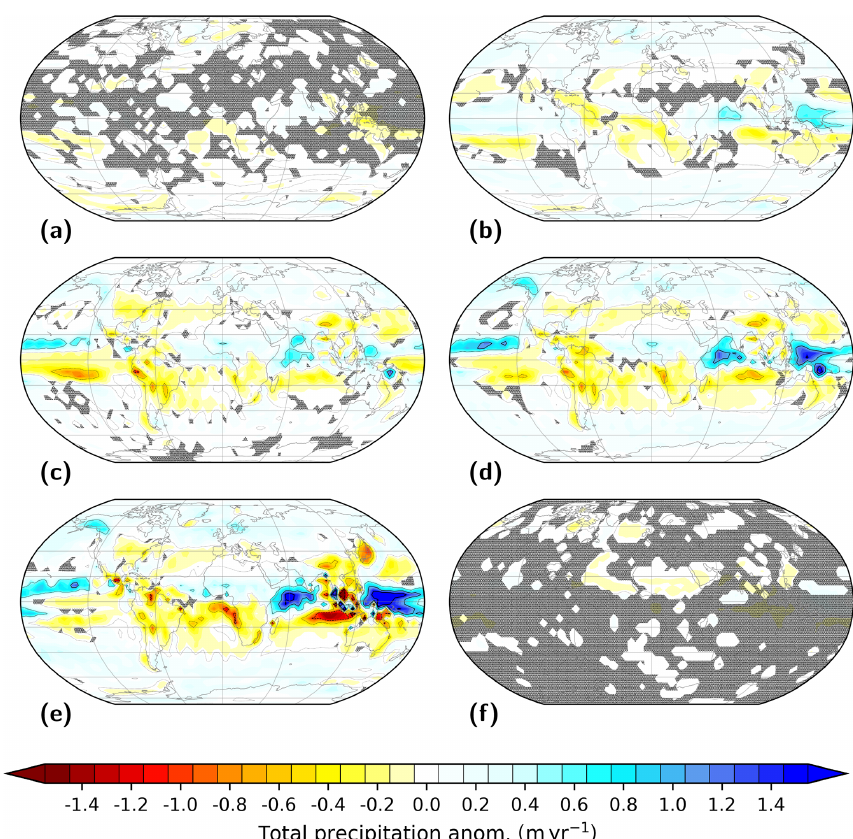
Figure 27. Sensitivity of annual mean total precipitation to variations in geography. Shown are anomalies with respect to pre-industrial (E280) for simulations (a) Ei280, (b) Ei400, (c) Eo280, (d) Eo400, and (e) Eoi400_GW. Panel (f) illustrates the impact of gateway changes in simulation Eoi400_GW in comparison to simulation Eoi400. Contours illustrate isolines of − 1 . 5myr − 1 (dashed), − 1 . 0myr − 1 (dashed, thin), 0.0myr − 1 (dotted, thin), 0.5myr − 1 (solid, thin), 1.0myr − 1 (solid), and 1.5myr − 1 (solid, thick). In hatched regions the anomaly is insignificant at the 95% confidence interval based on a t test. Total precipitation integrates contributions from large-scale and convective precipitation in the liquid and solid